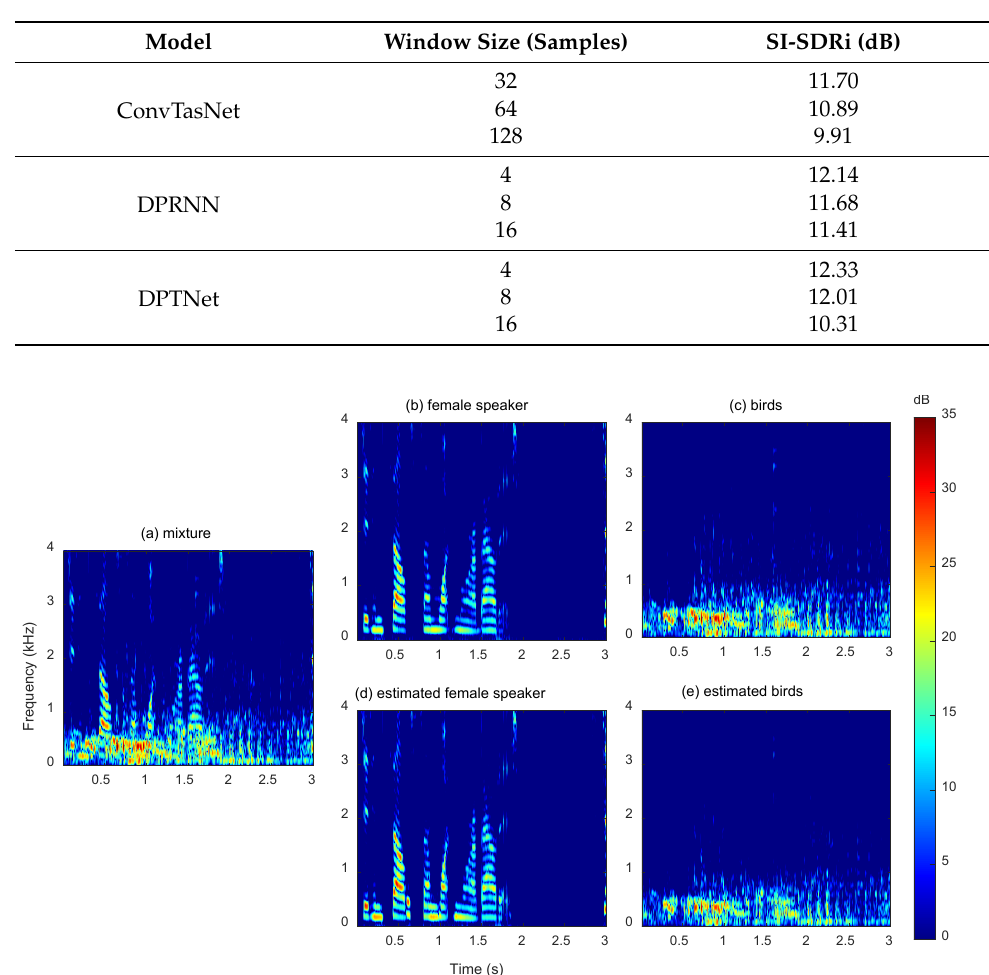
Figure 2. The spectrogram of ( a ) mixture, ( b , c ) two clear sources, ( d , e ) two estimated sources obtained by ConvTasNet with 32 samples, where two sources are from a female speaker and birds. Table 2. Average SI-SDR improvement (dB) on the test dataset for different networks with different window sizes.